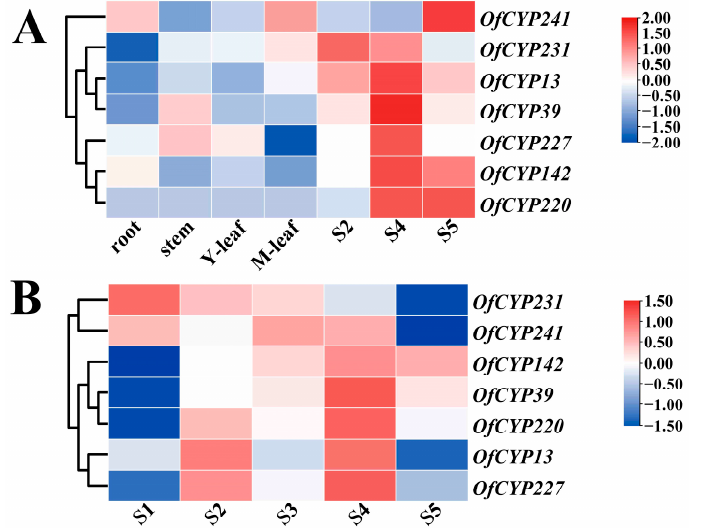
Figure 4. Expression profiles of key OfCYP s screened in different tissues and at different stages of flower development. ( A ) Transcription levels of key OfCYP s screened in different tissues. The different tissues were root, stem, and leaf (Y-leaf, young leaf; M-leaf, mature leaf); flower (S2, bud-eye stage; S4, full blooming stage; S5, flower fading stage). ( B ) Transcription levels of key OfCYP s screened in five distinct stages of flower development: S1, bud-pedicel stage; S2, bud-eye stage; S3, primary blooming stage; S4, full blooming stage; and S5, flower fading stage. The RPKM values obtained from the transcriptome data and FPKM (fragments per kilobase of exon model per million mapped fragments) values derived from the RNA-seq data in five distinct stages of flower development of OfCYP s were normalized by log 2 transformation. The heatmap was generated by TBtools software.